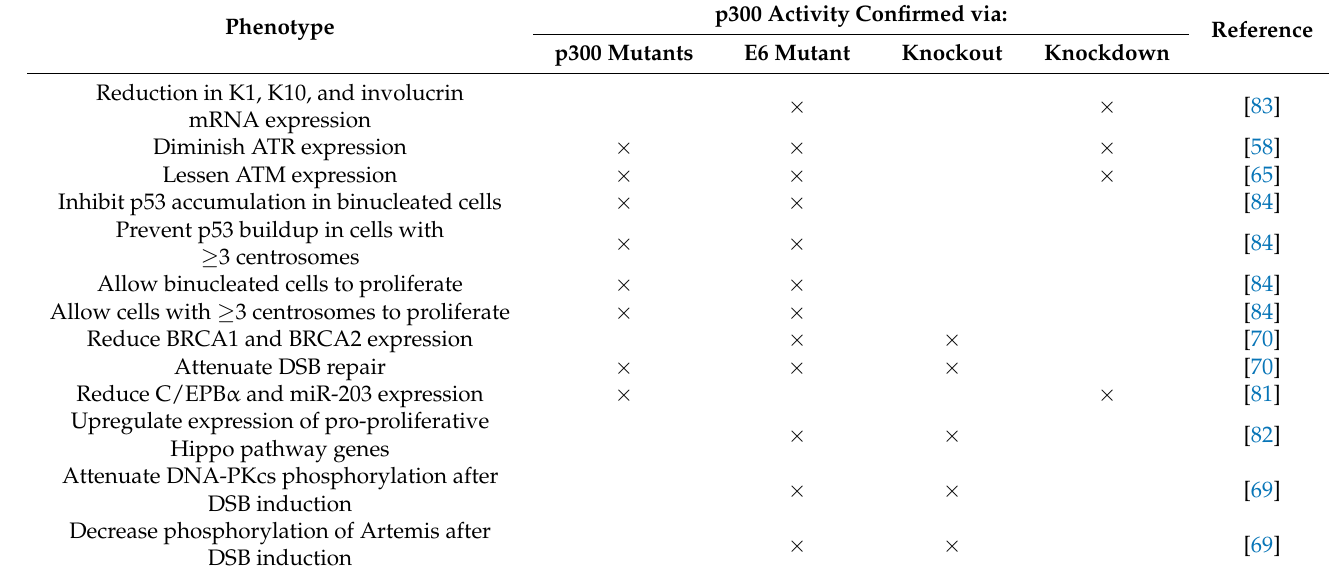
Table 3. Phenotypes of HPV8 E6 that have been confirmed to be through the destabilization of p300. p300 mutants include S1834E and S1834A. E6 mutant refers to HPV8 E6 ∆ 132-136. Knockout and Knockdown are via siRNA and HCT cells without p300,